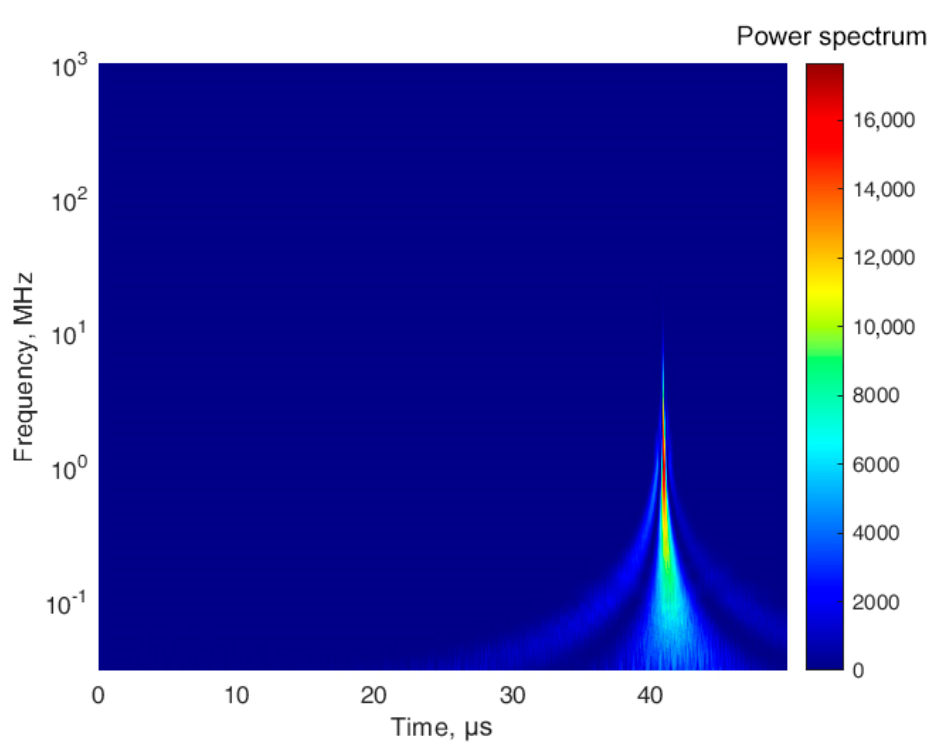
Figure 6. Wavelet spectrum of upward streamer corona current impulse.